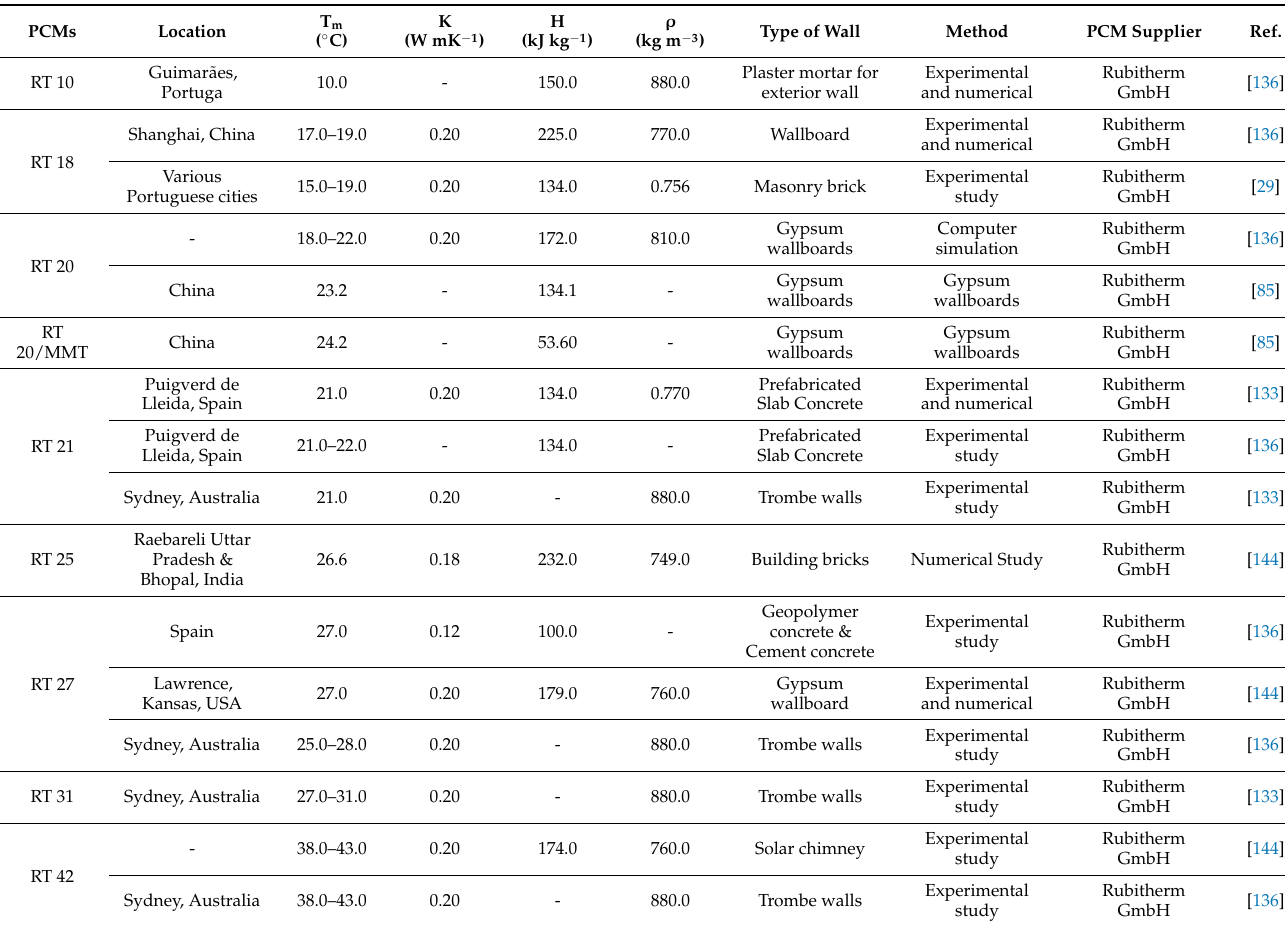
Table 11. Thermal properties of commercial PCMs used in different wall components, as discussed in the